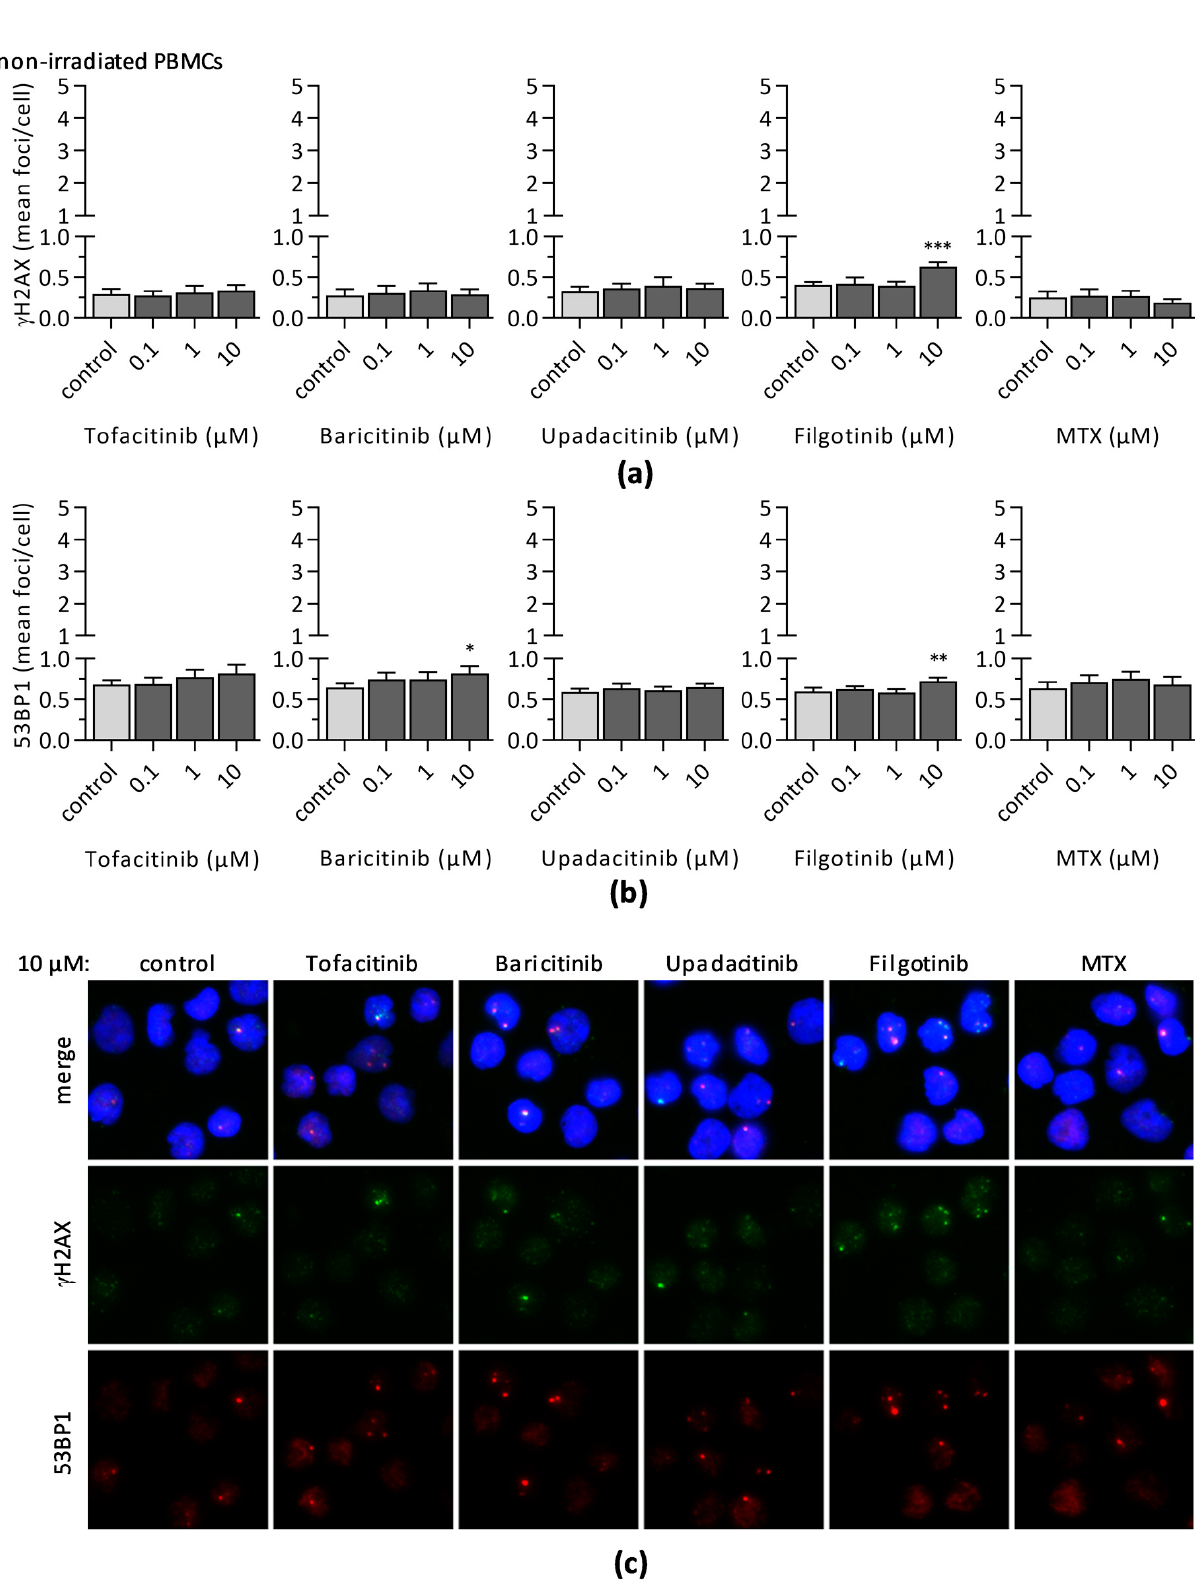
Figure 5. The mean number of ( a ) γ H2AX and ( b ) 53BP1 foci per cell were assessed, as markers for induced DNA double-strand breaks, 24 h after treatment of unstimulated PBMCs with indicated JAKi or MTX concentration. Diagrams display the mean ± SEM of seven independent experiments (*** p ≤ 0.001; ** p ≤ 0.01; * p ≤ 0.05). ( c ) Representative immunofluorescence microscopy images of PBMCs from one donor treated with either 10 µ M JAKi or MTX. Colors indicate DNA/DAPI (blue), γ H2AX (green), and 53BP1 (red).